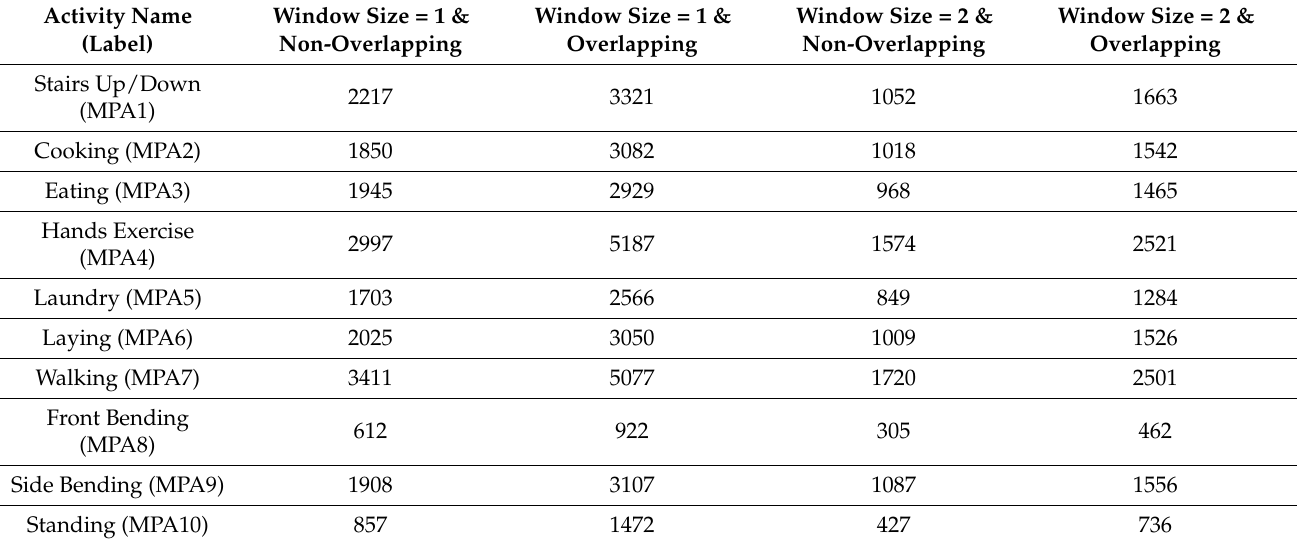
Table 7. Features Extracted Dataset Description using Different Window Size and